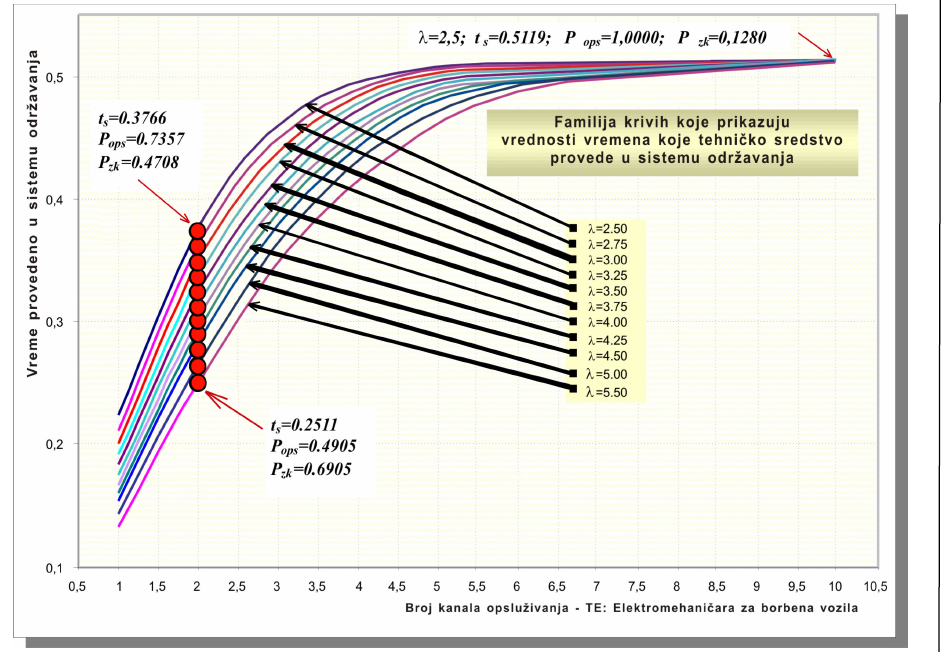
Figure 15 – Retention time for the technical means in the maintenance